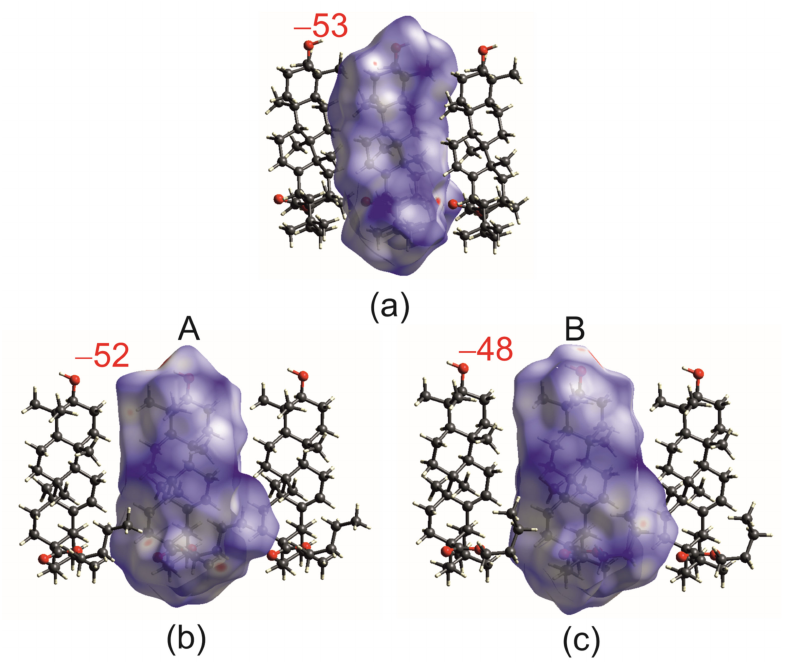
Figure 7. Intermolecular energies (kJ/mol) between molecules in R HH ribbons in ( a ) P 2 1 -but-OA and ( b ) R 3-but-OA molecule A, ( c ) R 3-but-OA molecule B. For one molecule, Hirshfeld surfaces mapped with d norm are shown. The energy values color match the color in Table S4.